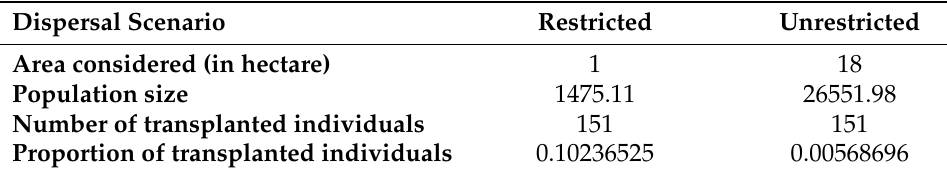
Table A3. Proportion of transplanted individuals in the Clar é e population.